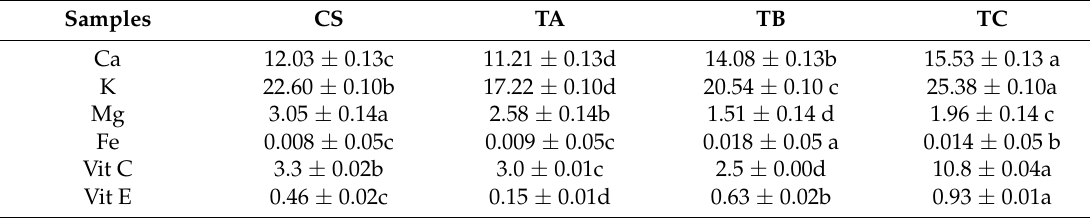
Table 3. Mineral composition (mg/L) of smoothies supplemented with Moringa